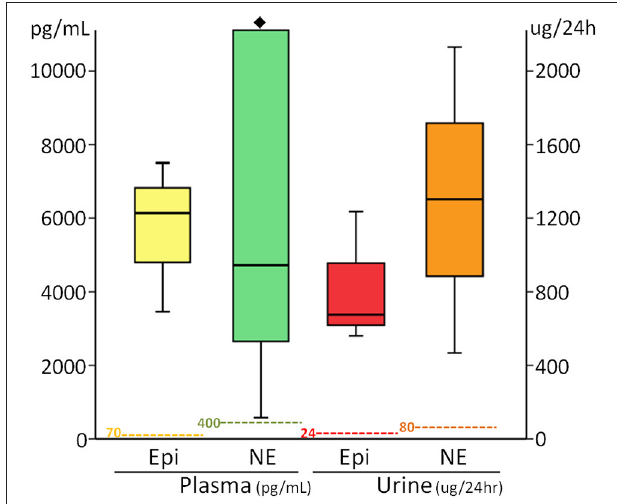
FIGURE 3 | Box-plots show significant elevation of plasma and urine catecholamine concentrations in patients with enterovirus 71-related heart failure. Dash lines indicate individual upper limits of normal. (cid:7) , Outliers: the patient’s values that are between 1.5 and 3 box lengths from either end of the box. Epi, epinephrine; NE,